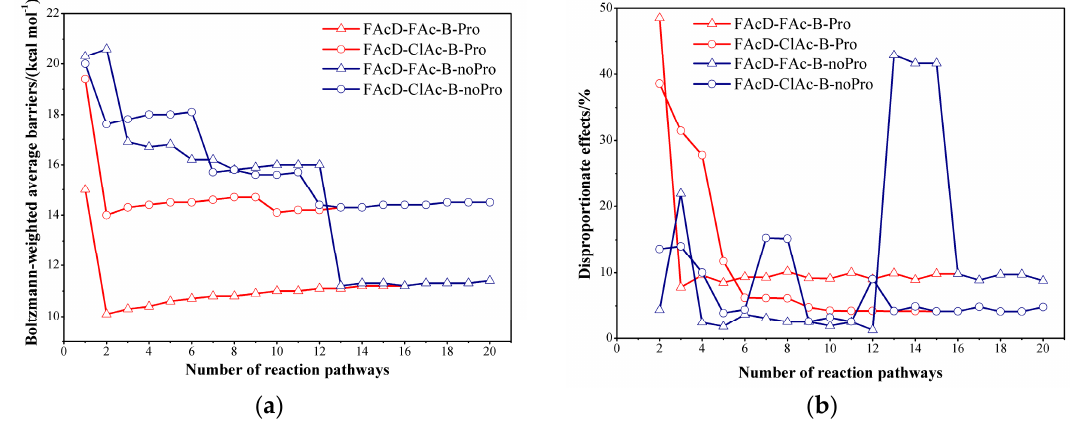
Figure 3. The convergence of ( a ) Boltzmann-weighted average barrier and ( b ) disproportionate effect of systems with protocols (FAcD-FAc-B-Pro and FAcD-ClAc-B-Pro) considered, and systems without protocols considered (FAcD-FAc-B-noPro and FAcD-ClAc-B-noPro).